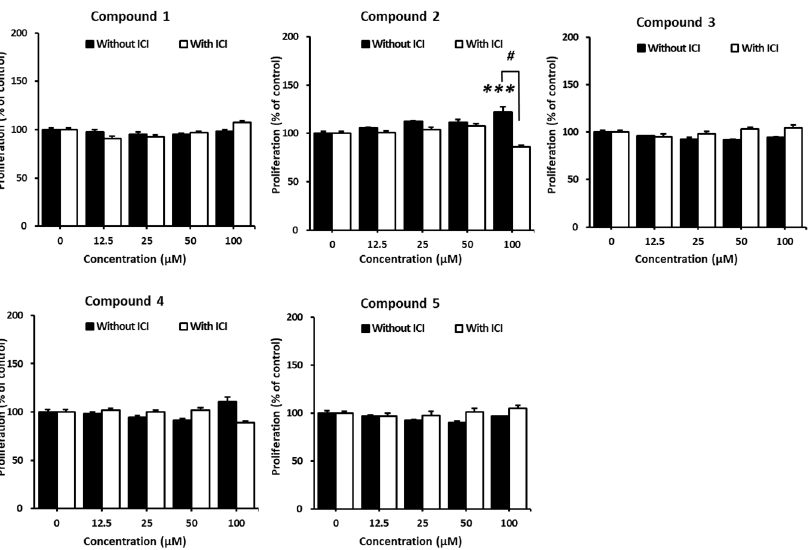
Figure 4. Estrogenic effects of the isolated compounds ( 1–5 ) in the presence or absence of ICI 182,780 measured by the E-screen assay on MCF-7 cells. Cell viability is expressed as the mean ± SEM. *** p < 0.001 compared to the non-treated group; # p < 0.05 compared to the ICI-treated group at the same concentration of samples. Data are represented as the mean ± SEM.